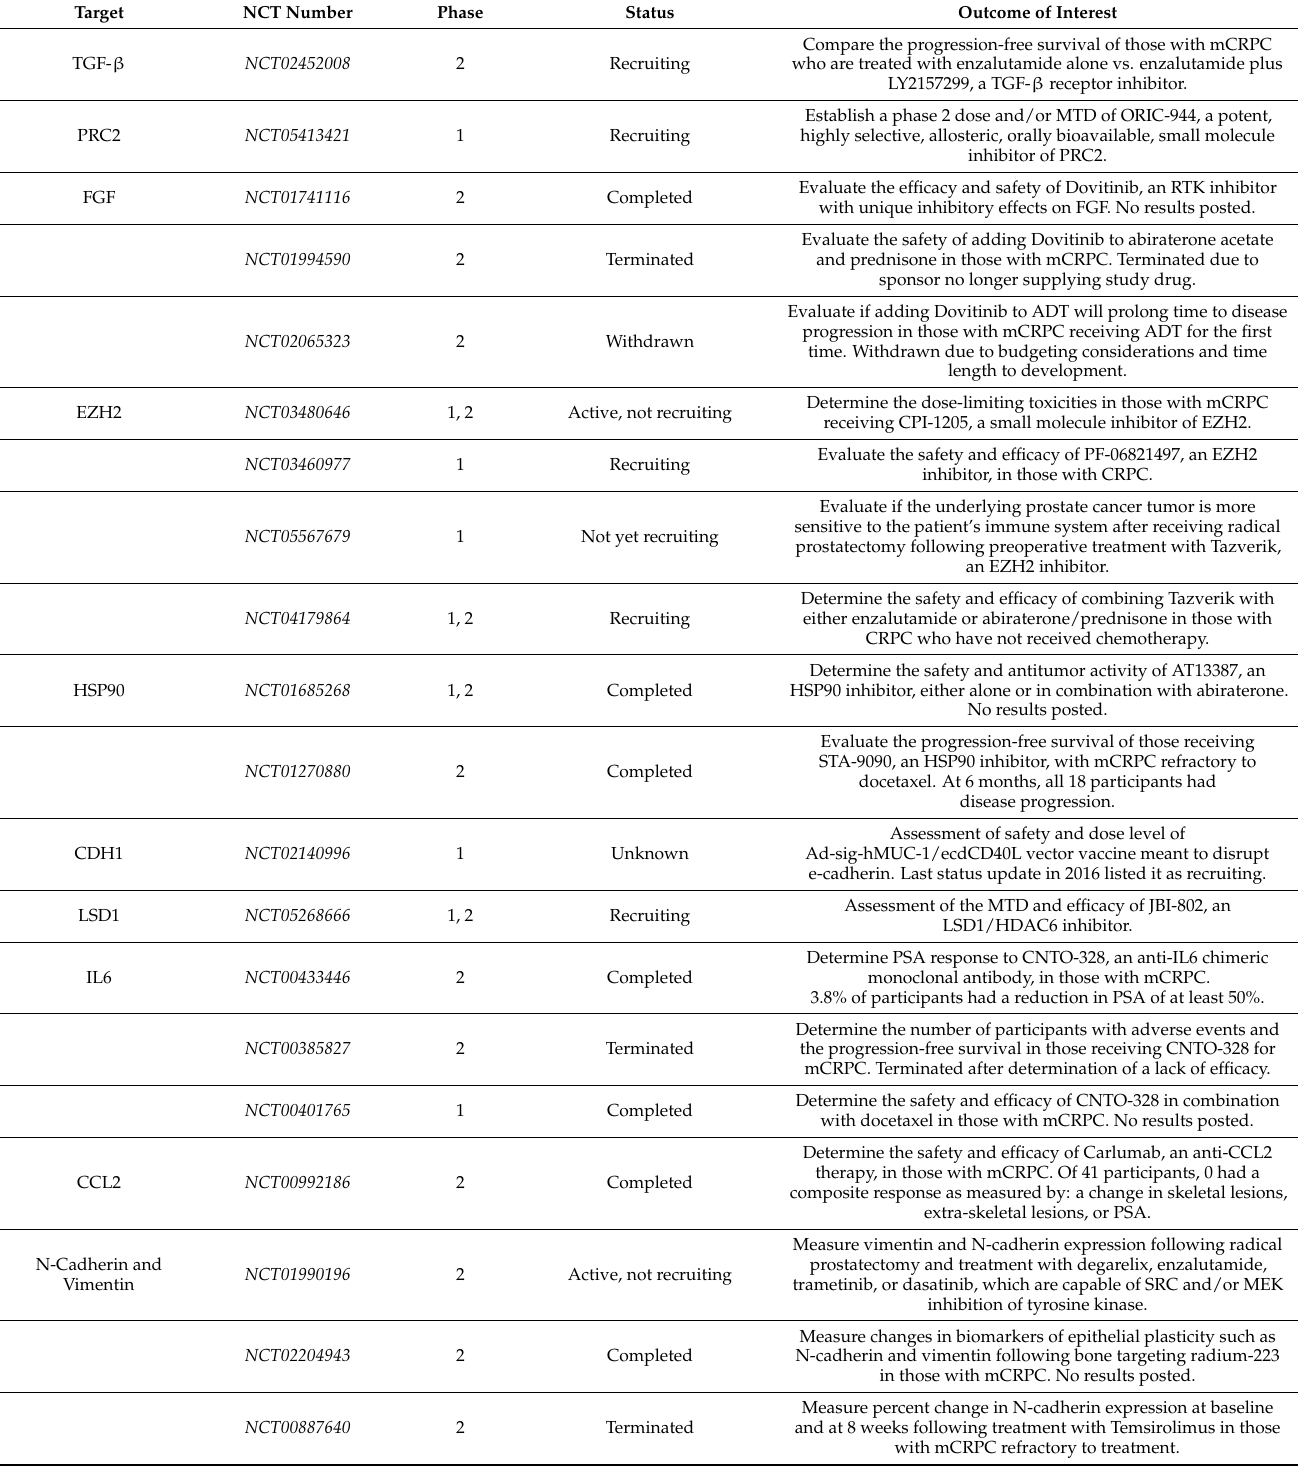
Table 1. List of clinical trials involving the EMT biomarkers of interest with investigational therapies targeting those biomarkers (https://clinicaltrials.gov/, accessed on 15 February 2023).